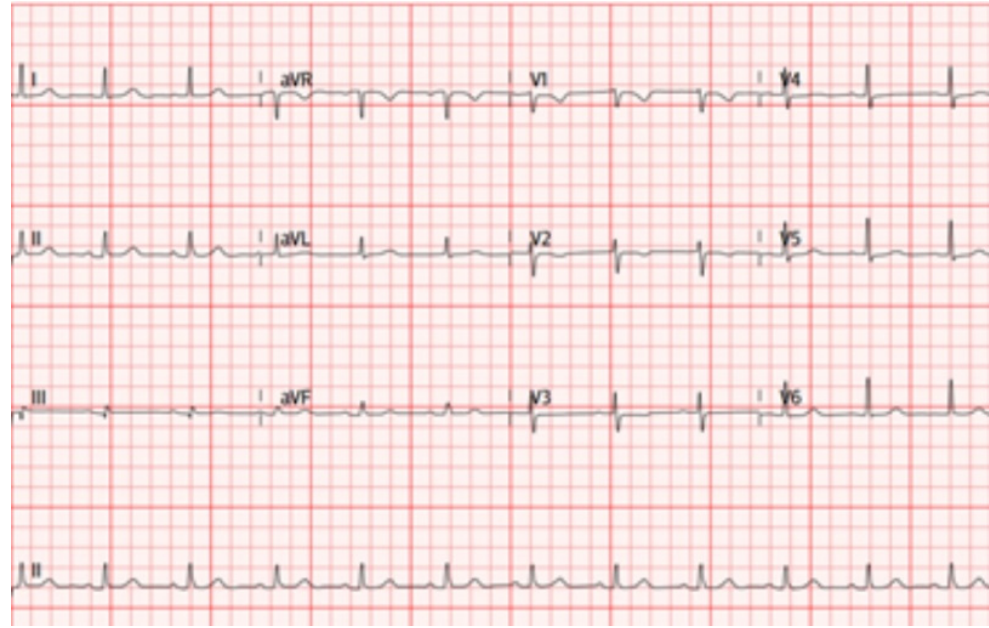
Figure 6. CMR patient IV.16. Right ventricle of normal volumes: end-diastole volume 70 mL/m 2 , end-systole volume 33 mL/m 2 and normal systolic function, ejection fraction 53%. No dyskinetic areas or focal aneurysmal dilatations were observed. There is no late enhancement in myocardial suppression sequences suggesting necrosis/fibrosis. ( A ) short axis; ( B ) four chambers; ( C ) long axis, four chambers.